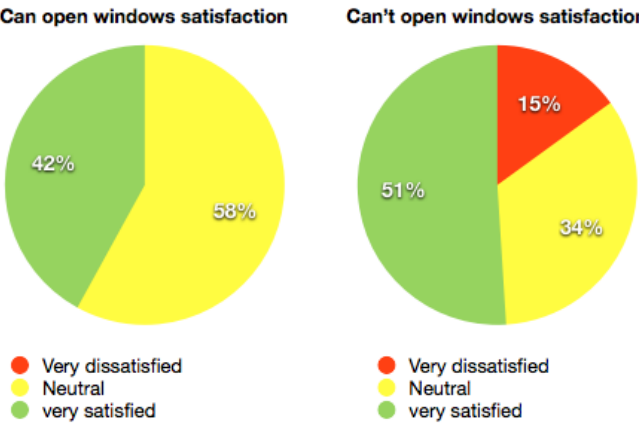
Figure 8. People’s satisfaction correlated with the operability of